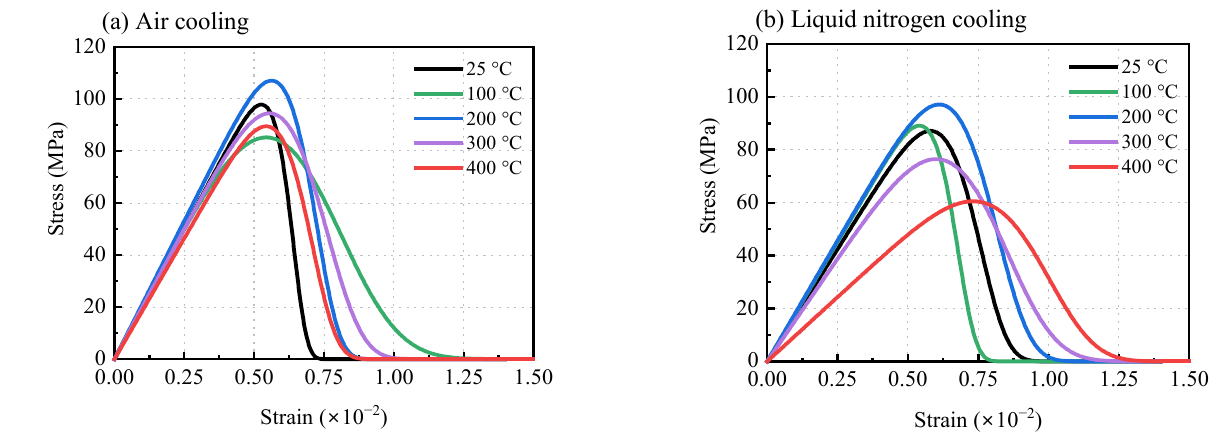
Figure 7. Theoretical stress–strain curves of heated granite after different cooling treatments (calcu- lated by average value).